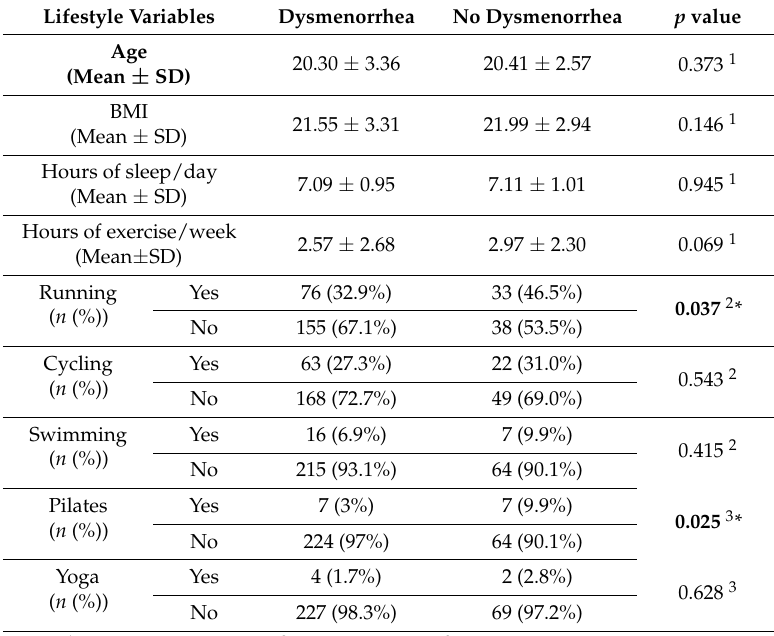
Table 1. Comparison of variables among women with and without dysmenorrhea.